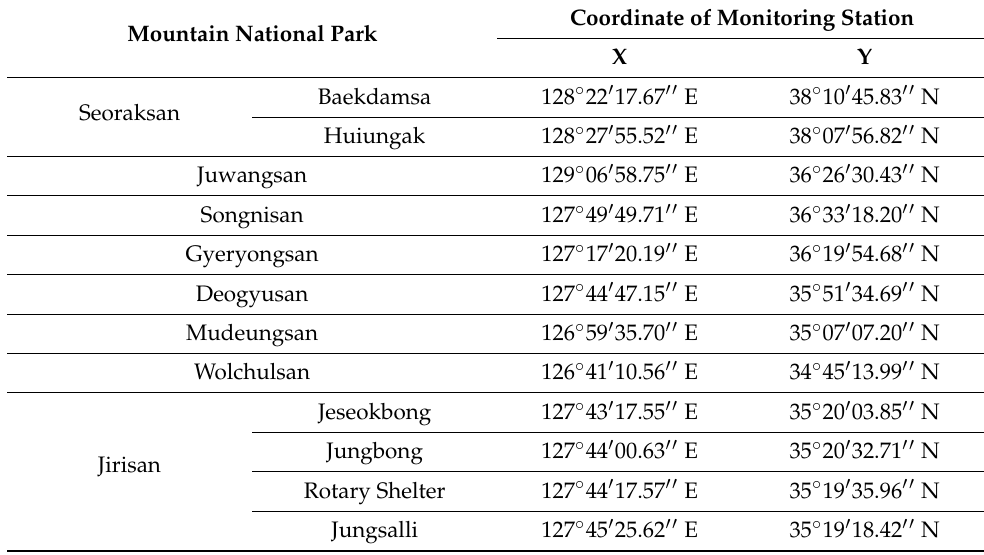
Figure 2. Current status of twelve KIGAM-LAMOS landslide monitoring stations in South Korea. Table 2. Installation locations of the landslide monitoring stations in eight national